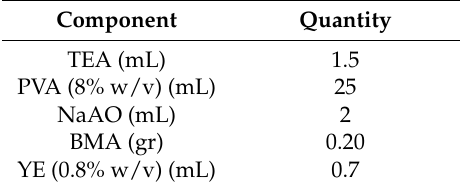
Table 2. Composition of the liquid solution for PVA/NaAO